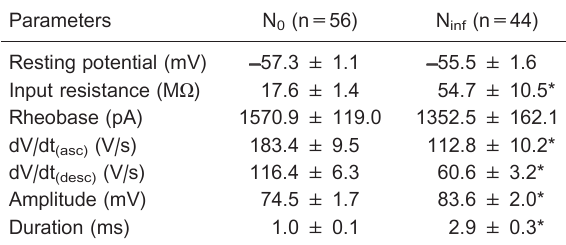
Table 1. Electrophysiological properties of N 0 and N inf cells in dorsal root ganglia.